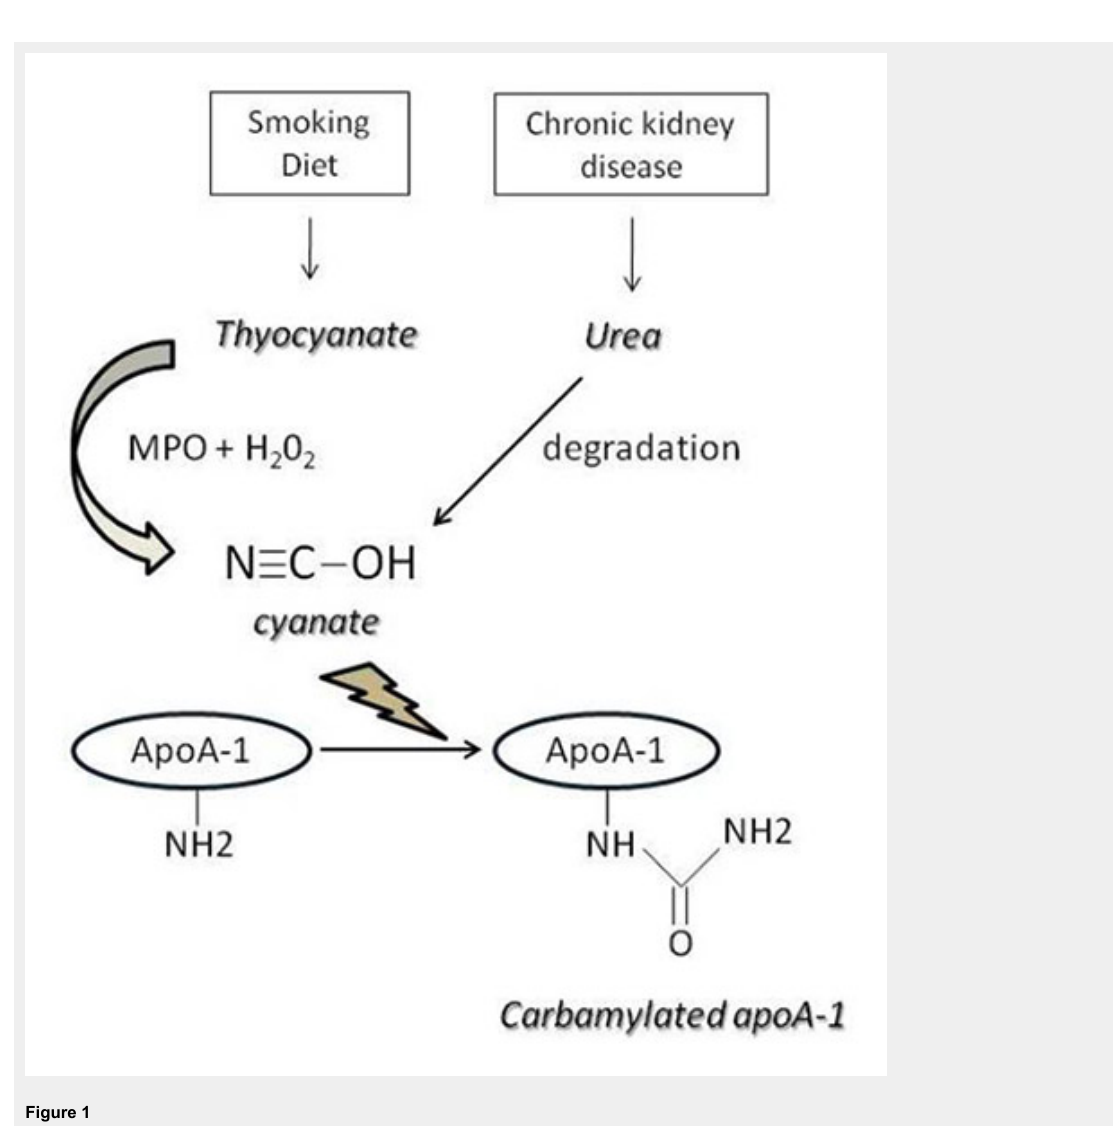
Mechanisms of apolipoprotein A-1 (apoA-1) carbamylation. MPO =